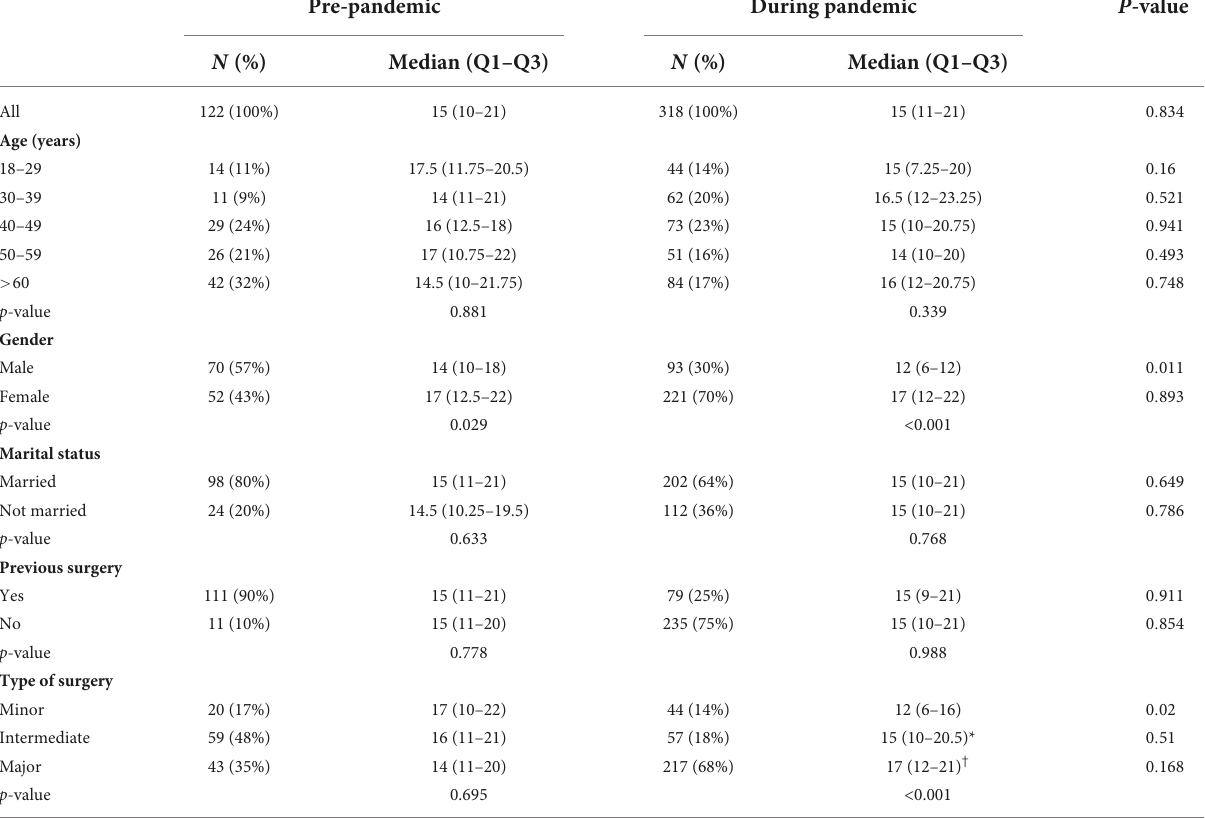
TABLE 4 The Amsterdam Preoperative Anxiety and Information Scale (APAIS) score for pre-pandemic and during-pandemic groups. Pre-pandemic During